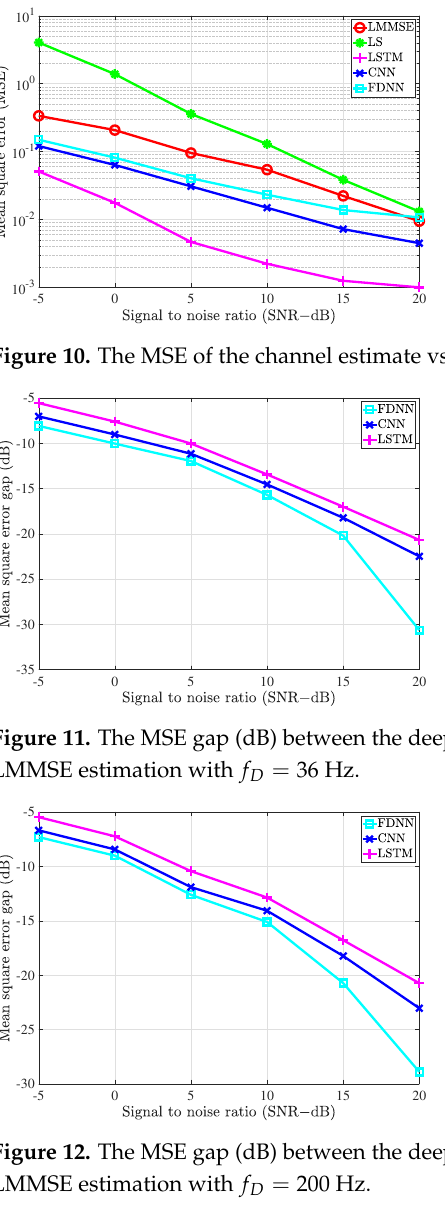
Figure 9. The MSE of the channel estimate vs. the SNR level with f D = 36 Hz.